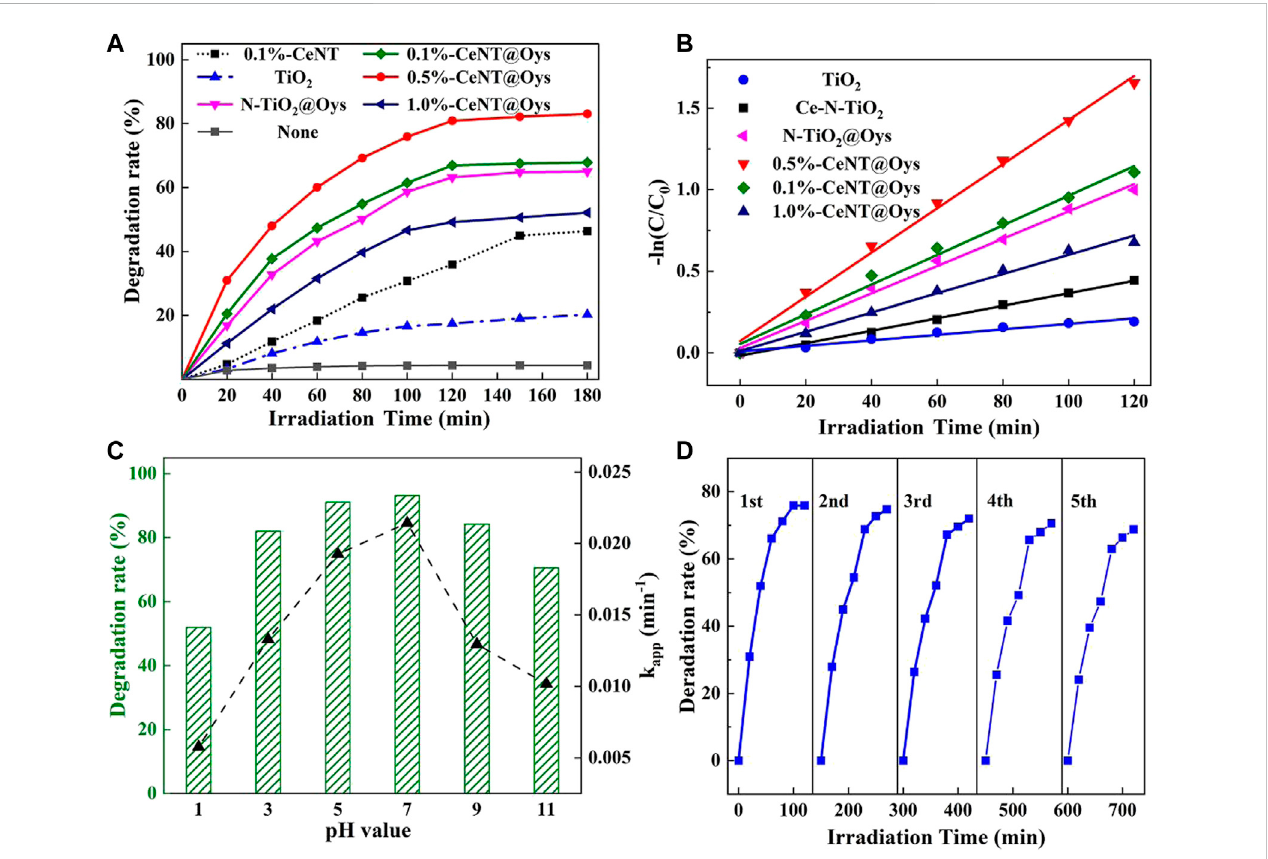
FIGURE 8 (A) Photodegradation ef fi ciency of PMG under visible light irradiation using various types of catalyst samples; (B) kinetic pro fi les of PMG degradation results using various types of catalyst samples; (C) effect of initial pH on PMG degradation; (D) the reusability experiment results of 0.5%-CeNT@Oys-500 °